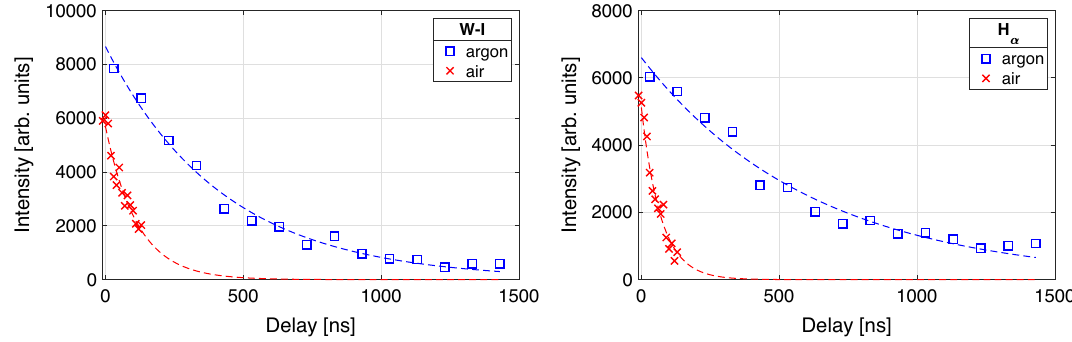
Figure 1. Detected maximum count (gate width 100 ns ) of the W-I (left) and H α (right) spectral lines at 643.97 nm and 656.28nm on untreated tungsten (W) tile using the same setup with ambient argon (blue squares) and air (red crosses) at atmospheric pressure. Exponential fits are indicated with dashed lines.